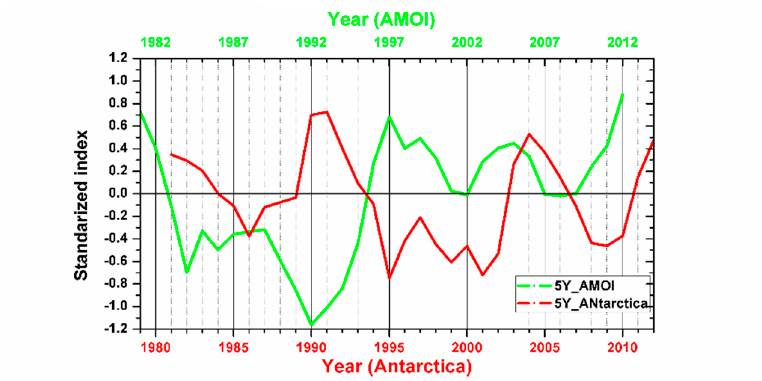
( b ) De-trended Atlantic Multidecadal Oscillation indices (AMOI) (Green) and Antarctican (red) ice sheet ME time series.